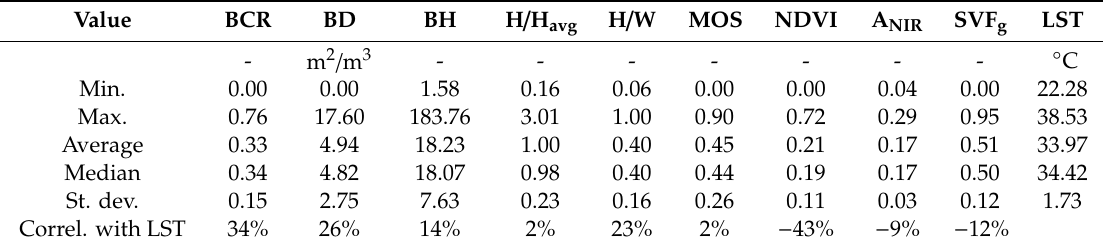
Table 10. Urban parameters and land cover characteristics at a census section scale.